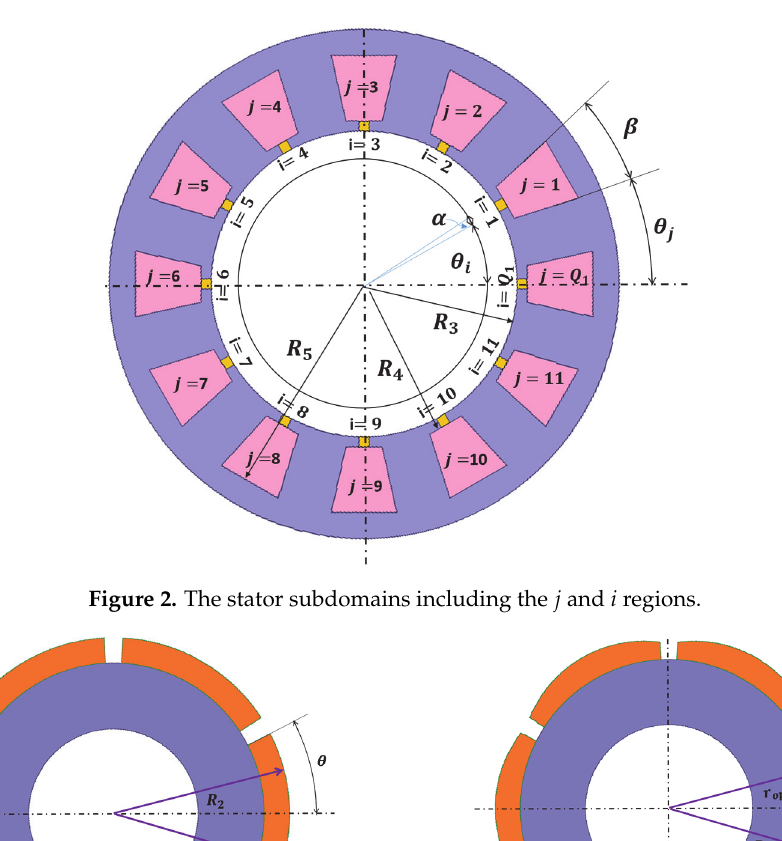
Figure 1. The geometrical representation of the investigated machines with ( a ) uniform rotor shape, ( b ) non ‐ uniform rotor shape.